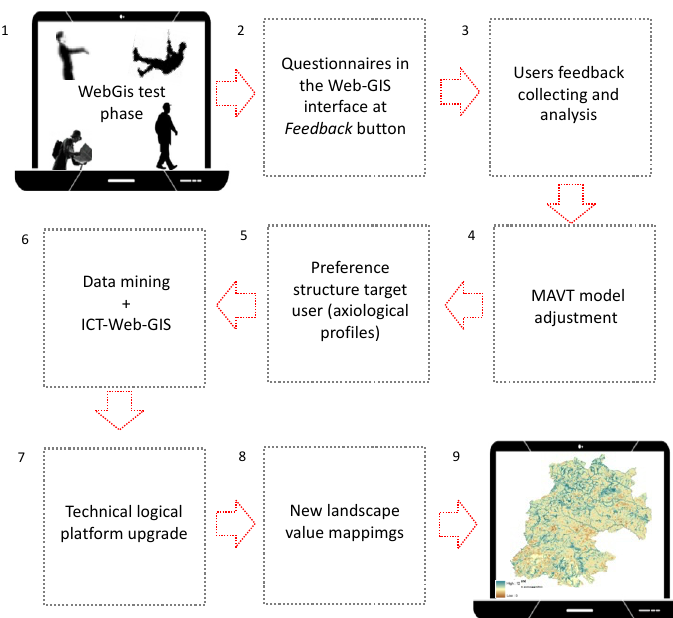
Figure 6. The ICT-Web-GIS interactive platform.